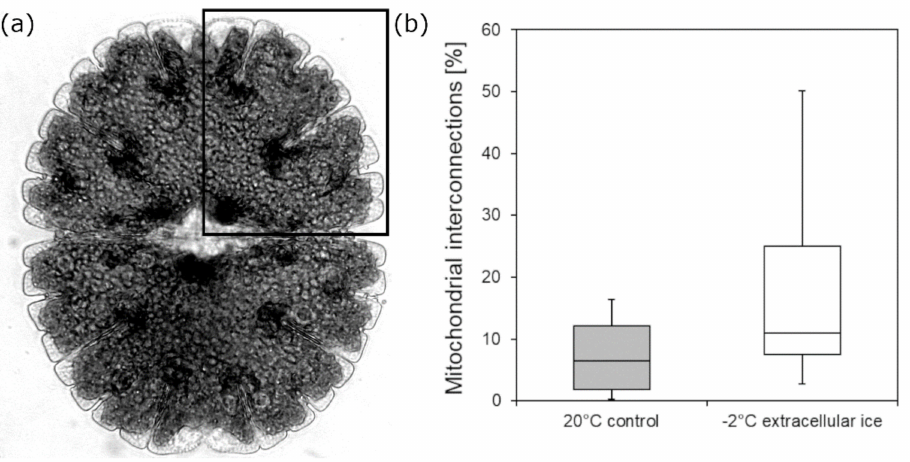
Figure 3. (a) Schematic depiction of the analyzed area in Micrasterias. (b) Mitochondrial fusions and contacts (%) in Micrasterias denticulata during extracellular freezing stress at − 2 ◦ C in comparison to controls at + 20 ◦ C determined by analysis of TEM micrographs (n = 10). Mean values were not significantly di ff erent (p = 0.069; t-test). Boxes indicate the median (horizontal line inside the box) and the 25th and the 75th percentile (bottom and top border). Whiskers indicate maxima and minima and extend maximum to 1.5 times